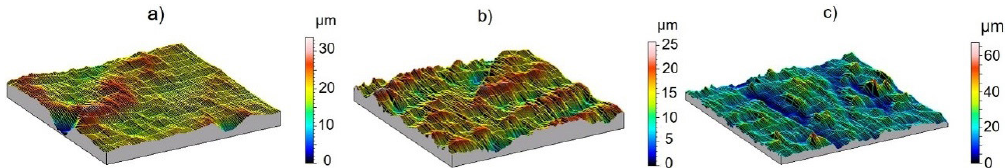
Figure 5. 3D surface profiles of composite samples: (a) untreated. (b) treated with UA and (c) treated with BA.